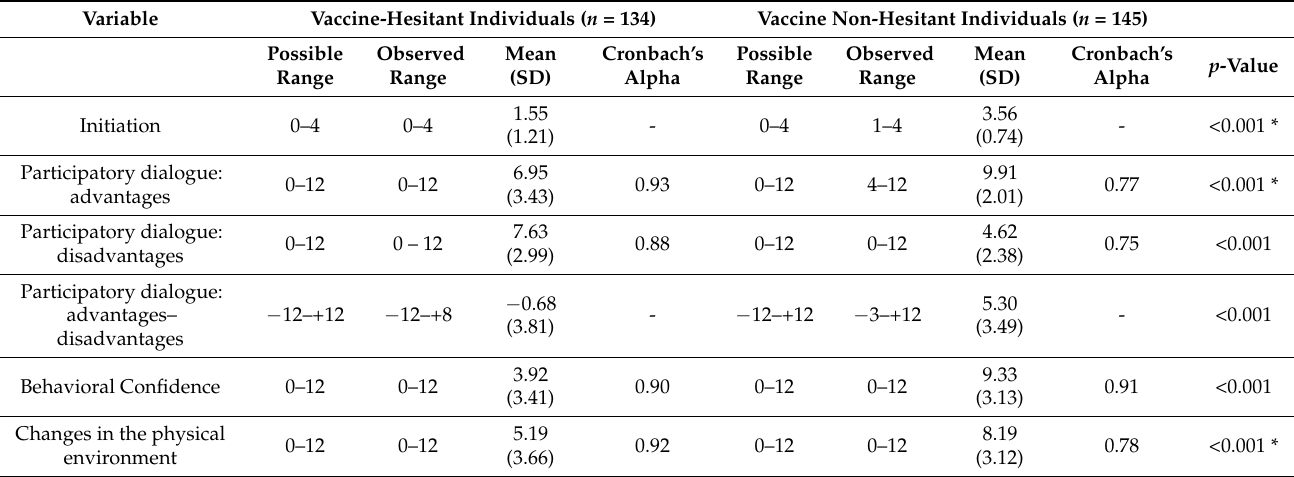
Table 2. Descriptive statistics for study variables with the test of group means between vaccine-hesitant and non-hesitant individuals.